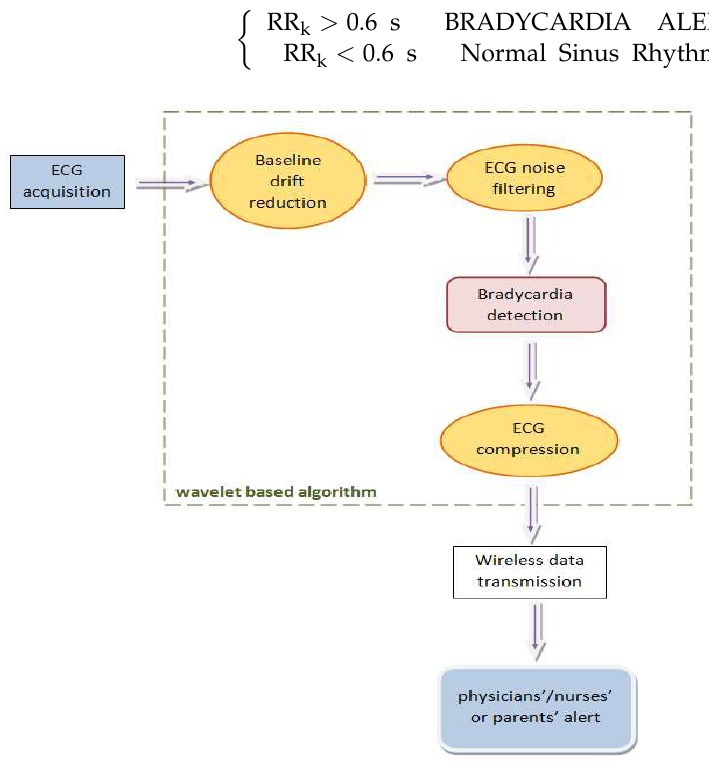
Figure 2. Structure of the automated monitoring system. Daily life signals reside in the time domain, still sometimes full information about the signal is not always visible. Thus there is a necessity to transform the signal from the time domain to other domains (such as the frequency domain [30]) to enable computer-assisted solutions. ECGs trace the variation of a voltage over time, with no information about the frequencies that might appear during the signal acquisition (a non-visible informa- tion). Wavelets check the frequency content of the signal at multiple resolutions of the analyzed